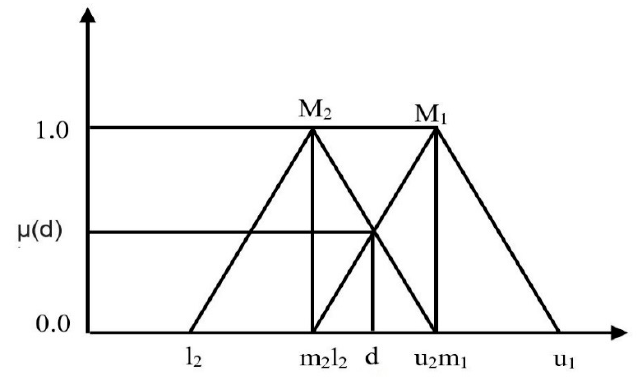
Figure 6. The intersection between M 1 and M 2.